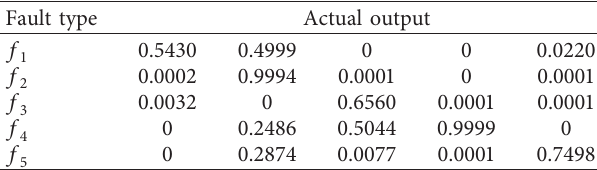
Table 4: BP neural network diagnosis results. Fault type